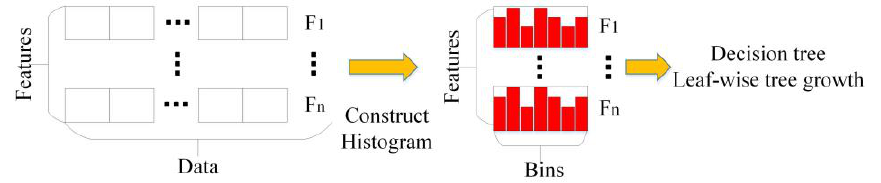
Figure 4. Histogram-based decision tree algorithm. The left part of the figure represents the organiza- tion form of the original data, and the middle part of the figure represents the histogram data.